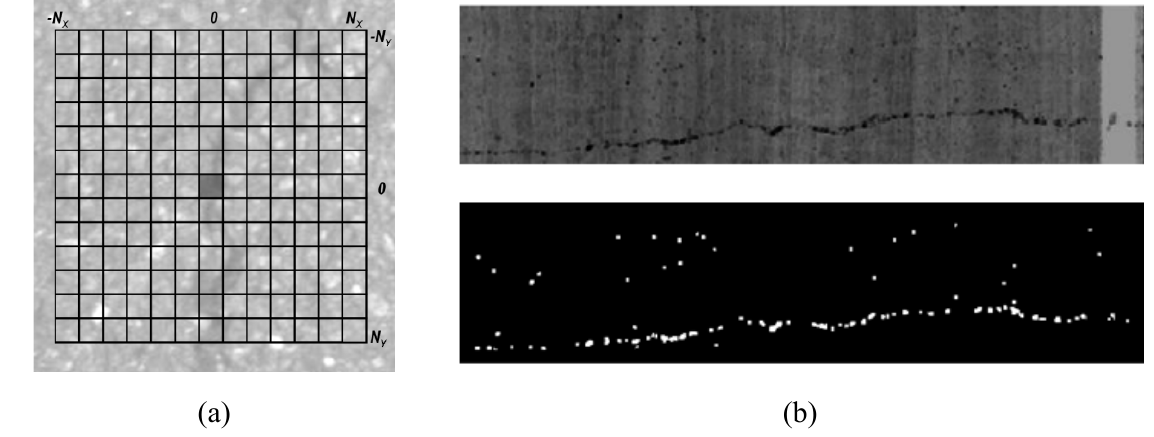
Figure 11. ( a ) Sliding window parameters; and ( b ) Upper : pre-processed image. Lower : mask with possible seed locations.